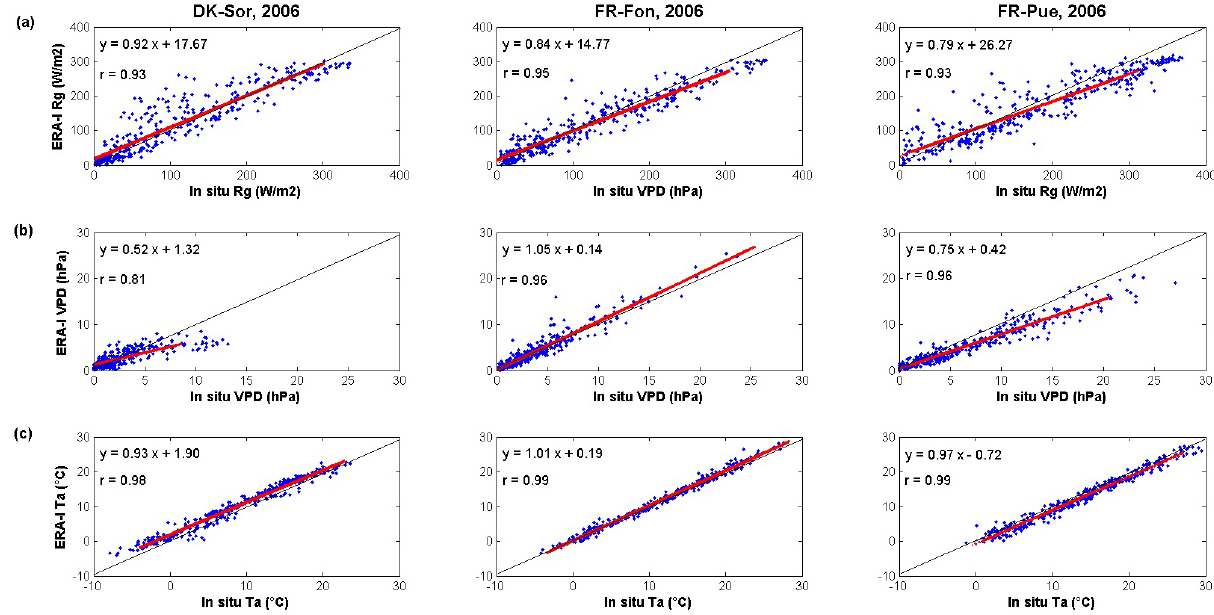
Figure 8. Comparison of in situ and ERA-I forcing: (a) global radiation ( R g ); (b) vapor pressure deficit (VPD); and (c) air temperature ( T a ). Red lines represent the linear fit to the data and the black lines are 1 : 1 lines. The coefficients of the linear fit and the correlation coefficients are shown in top left corner of the